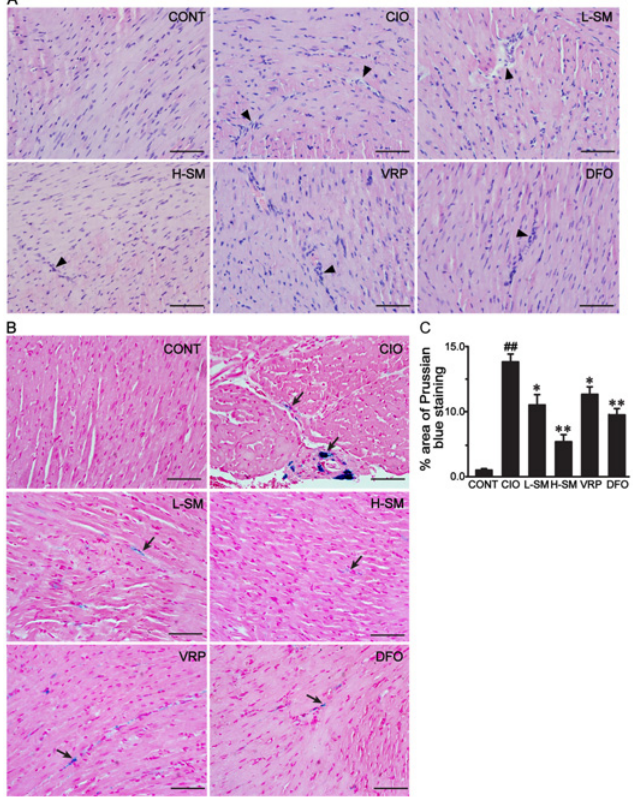
Fig 1. Effects of SM treatment on histological changes and iron deposition in mouse heart. Representative micrographs of H&E-stained heart tissues were obtained from each group to observe histological changes (A). The morphological location (B) and the percent area of iron deposition stained with Prussian blue (C) in each group are shown. The bar represents 50 μ m (original magnification, 400×). Cardiac injury (triangles) and iron deposition (arrows) are indicated in these microscopic photographs, respectively. Results are means ± SEM. ##P < 0.01 vs. CONT group; * P < 0.05, ** P < 0.01 vs. CIO group.